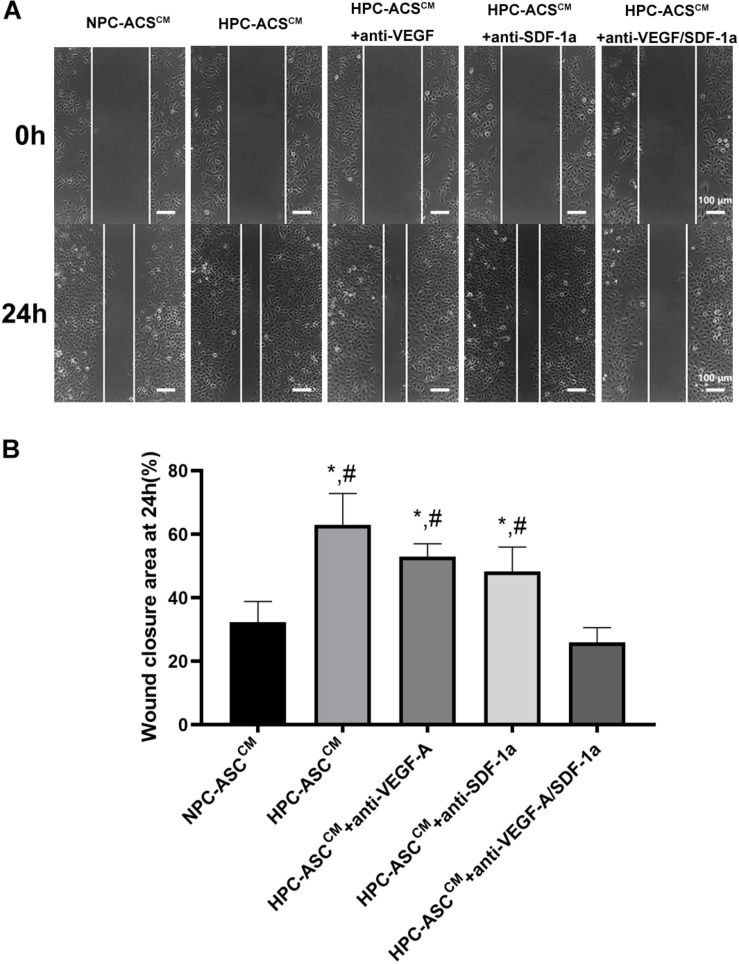
Wound healing assay in vitro. (A) The representative images of the HUVECs from each group at 0 and 24 h after scratching with a pipette head. Scale bar = 100 μm. (B) Quantitative analysis on wound closure as measured by the width covered by the migrated cells (n = 5, *denotes P < 0.05 vs. NPC-ASCCM; #denotes P < 0.05 vs. HPC-ASCCM + Anti-VEGF-A/SDF-1a).